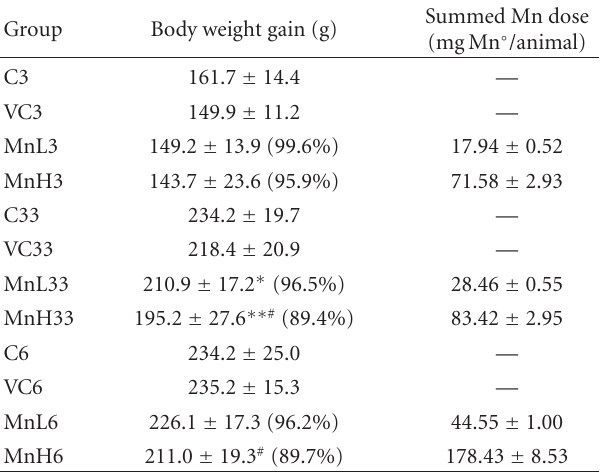
Table 2: Body weight gain of the rats during the treatment